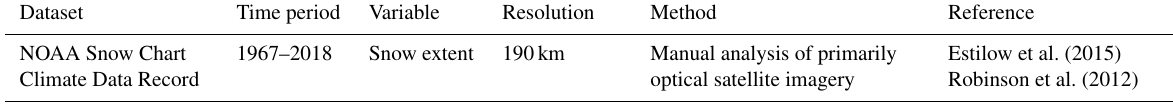
Table 1. Snow products combined to produce multi-dataset snow cover extent and snow mass datasets.